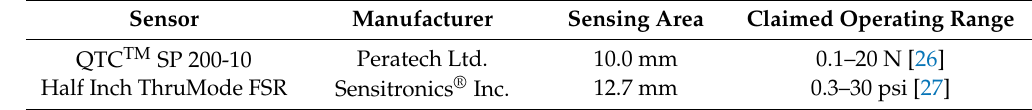
Table 1. Geometry and sensing properties of sensors used for evaluation.